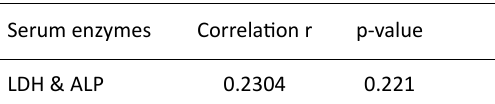
table 2. The difference in mean levels of serum enzymes (U/L) concentration among different stage of tumor in patients Serum Stage Stage Stage P -value